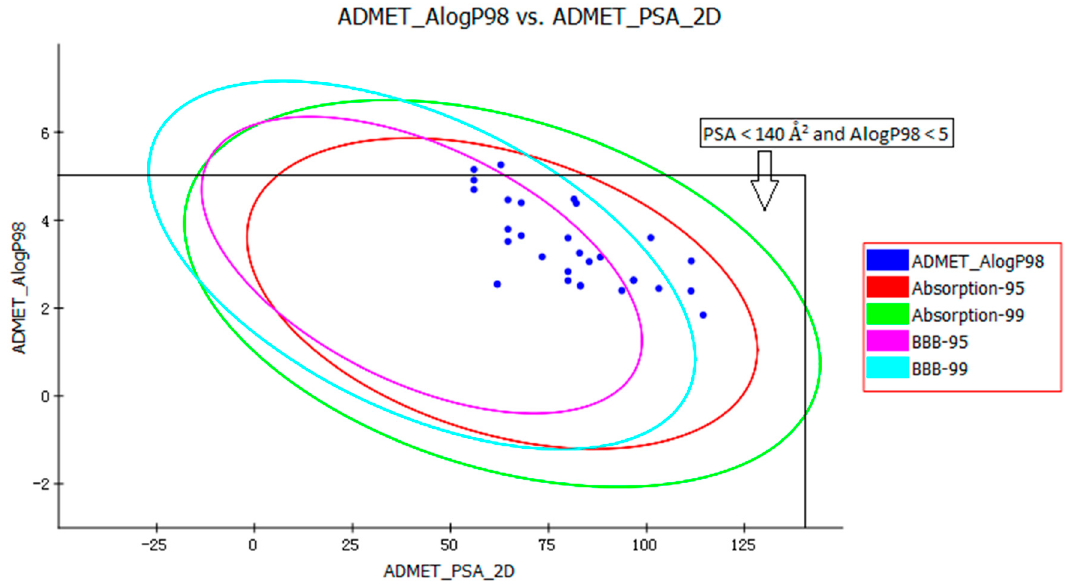
Figure 4. Plot of the two-dimensional polar surface area (PSA_2D) vs. the calculated ALogP98 for tested compounds showing the 95% and 99% confidence limit ellipses corresponding to the blood-brain barrier (BBB) and the human intestinal absorption (HIA) models.